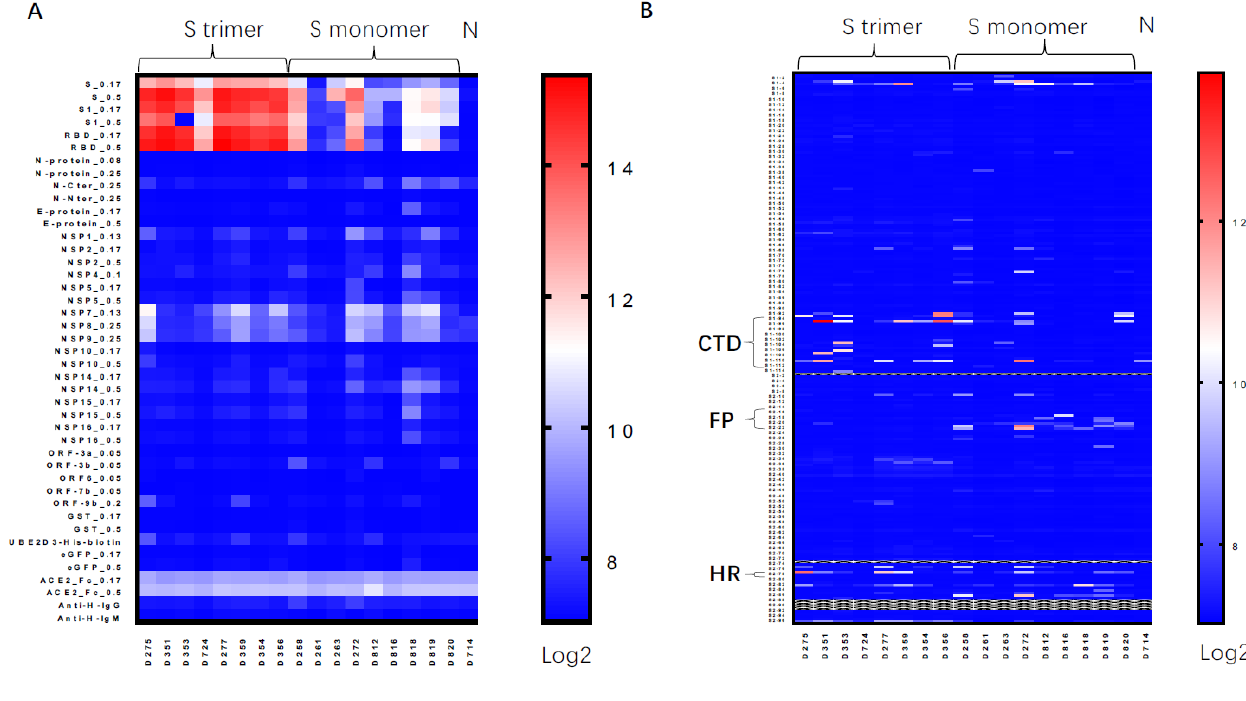
Figure 2. Protein/peptide array of serum antibodies induced by the Spike protein vaccines. ( A ) Protein-array assay for sera from mice immunized by the Spike trimer and Spike monomer; non-immunized mice using Spike (S_0.17 and S_0.5 mean proteins were printed at 0.17 or 0.5 mg/mL, respectively); the S1 subunit of Spike, the receptor-binding domain (RBD), and other viral proteins. ( B ) Linear peptide array using linear peptides of Spike proteins. C-terminal domain right after RBD (CTD; Peptides S1-93-S1-113); fusion peptide (FP; Peptides S2-14-S2-23); heptad regions (HR; Peptides S2-78).